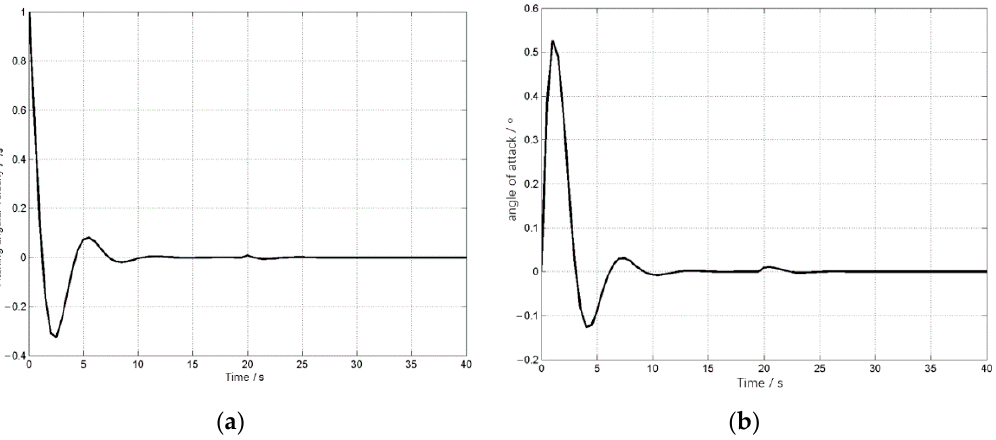
Figure 8. ( a )State-response graph of the pitching angular velocity; ( b ) state-response graph of the angle of attack.